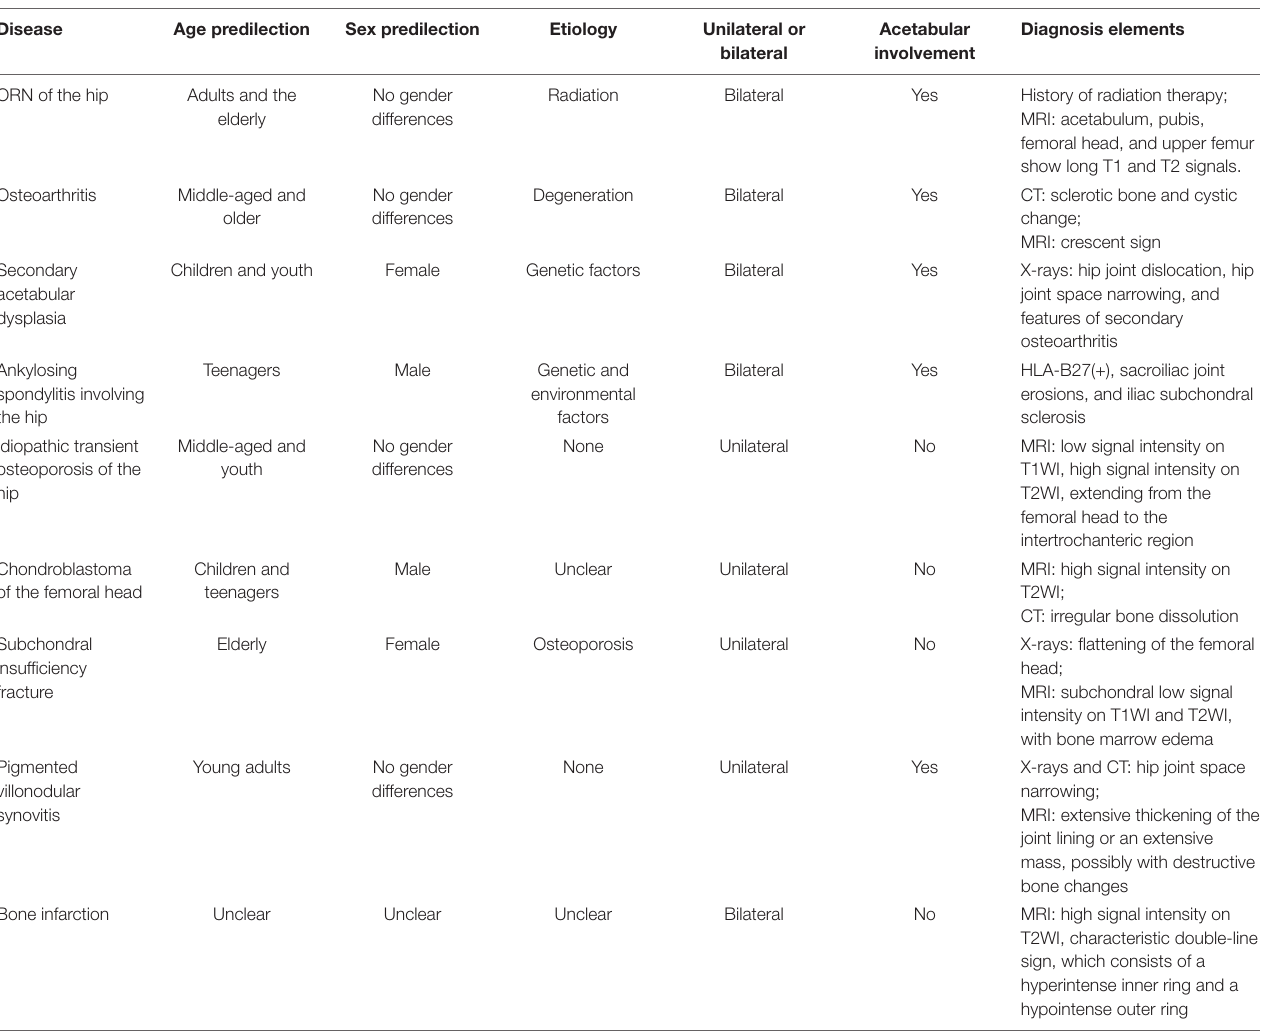
TABLE 2 | Differential diagnosis of ORN of the hip